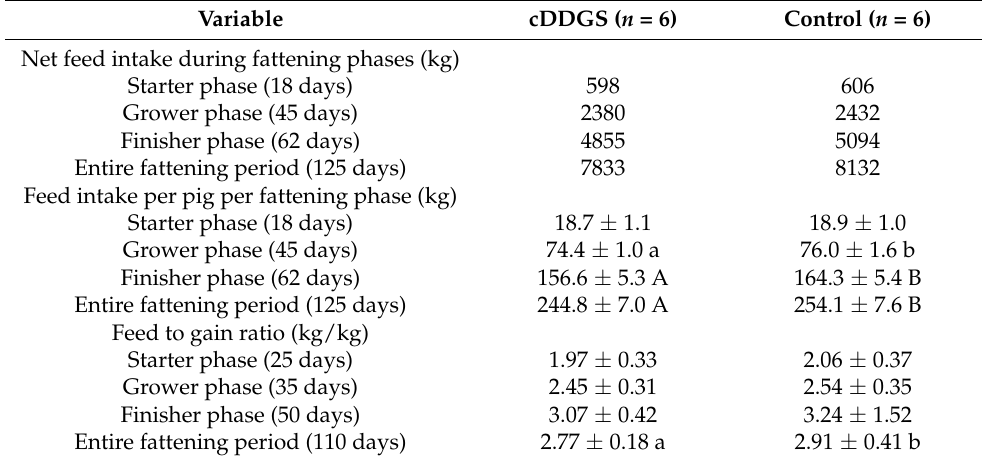
Table 4. Summary of daily feed intake and feed conversion during the three phases of pig fattening.